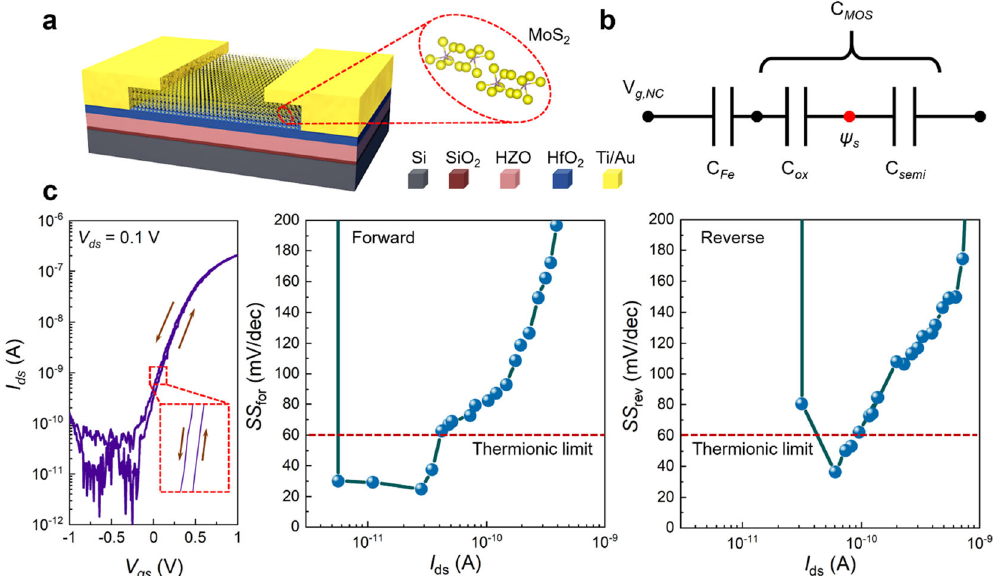
Fig. 5 Fabrication and electrical properties of MoS 2 NCFET. a Schematic of fabricated MoS 2 NCFET based on HZO with HfO 2 (9 nm). b Equivalent capacitance schematic of the MoS 2 2D-NCFET (V g,NC , ψ s represents the negative capacitance gate voltage and surface potential, C MOS , C semi , C ox , and C Fe represent the capacitance of MOSFET, MoS 2 , HfO 2 , and HZO, respectively.) c Transfer characteristic curve ( I ds – V gs ) and SS versus I ds characteristics of the MoS 2 NCFET at V ds = 0.1